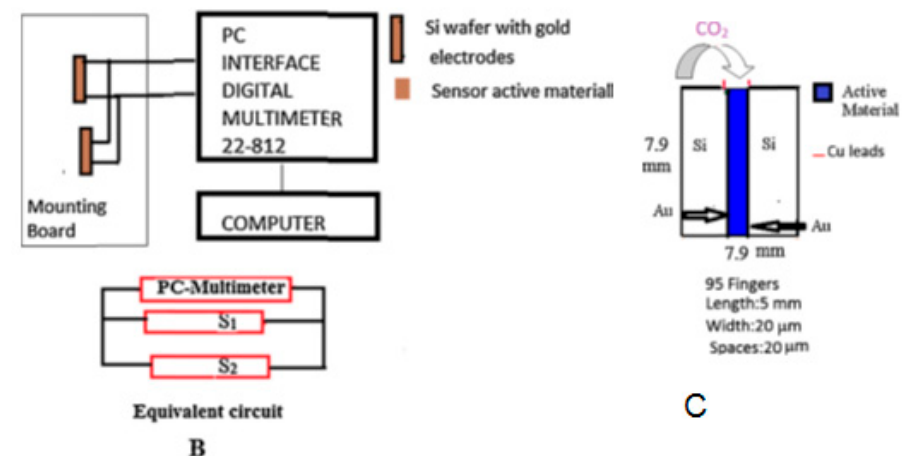
Figure 17. Twin sensors in parallel configuration. ( A ) The arrangement of the sensors and the measurement details. ( B ) The equivalent circuit of the arrangement of the sensors (S1 and S2). ( C ) Sensor dimensions. Reproduced with permission from Reference [5].